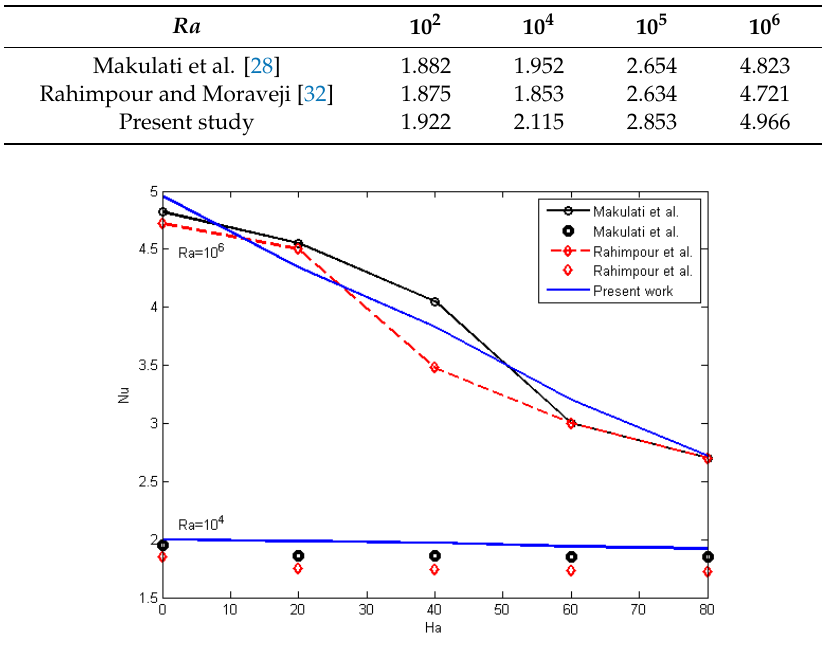
Figure 4. Profiles of Nusselt number in comparison with References [28] and [32] at ϕ = 0.04, AR = 0.4, and α = 0.